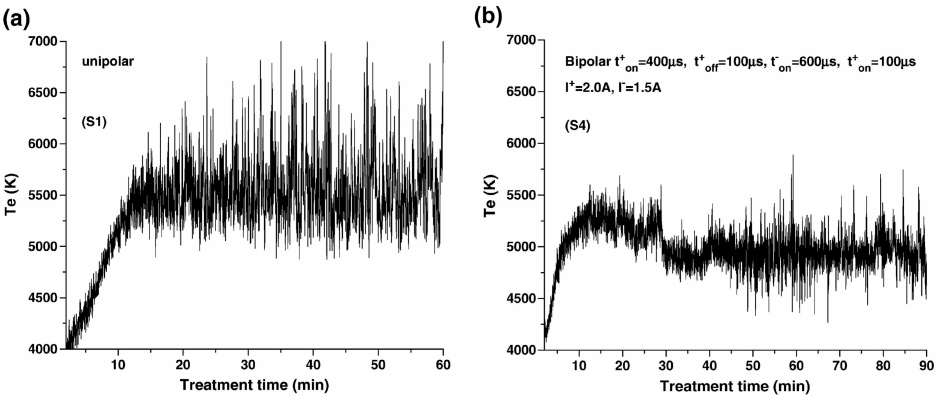
Figure 5. Comparison between two electron temperature ( T e ) profiles without and with cathodic electricity. Coating operations have been performed on the samples of 1100 alloy. ( a ) The profile of T e is plotted versus time for PEO with a unipolar current (without cathodic current involved). ( b ) The profile of T e is plotted for PEO with a bipolar current (with cathodic current) at R pn = 8/9. Note that T e of unipolar current is generally higher in the baseline and fluctuates with larger amplitude, compared with that of the bipolar current